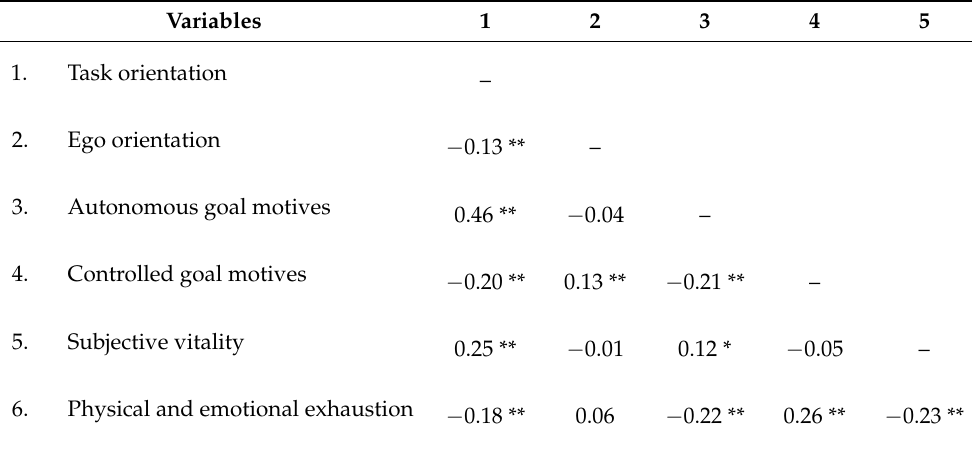
Table 2. Correlations between study variables.